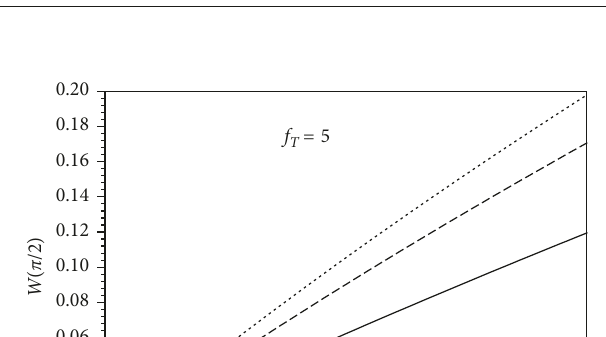
Figure 3: Dimensionless displacement W index, n , of the semielliptic FGM curved beam for different values of λ ( δ 0 . 5). (cid:31)